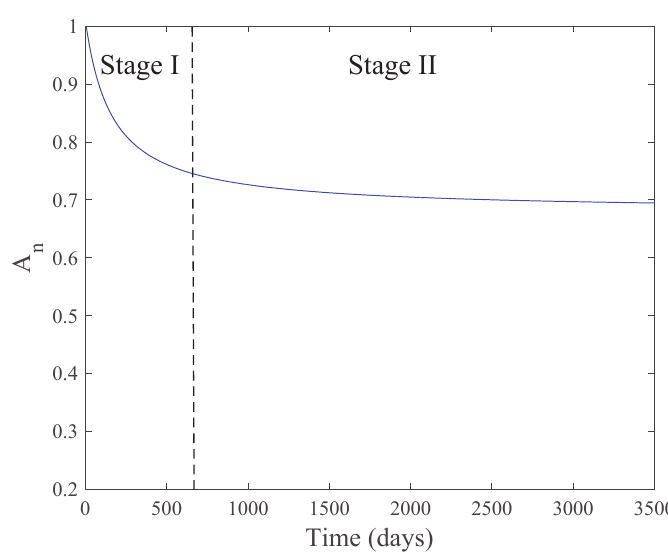
Fig. 3. Schematic presentation of the two stages in A n decline. (I) initial more pronounced drop due to compaction and irreversible fouling;(II) gradual decline mainly caused by irreversible fouling [29].